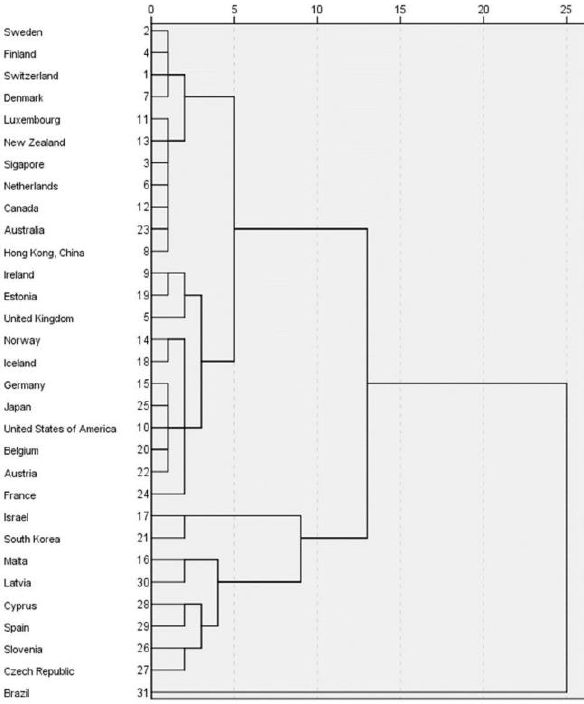
Figure 6. Formation of Clusters of the Most Innovative Countries (in 2012) and Brazil‟s Position